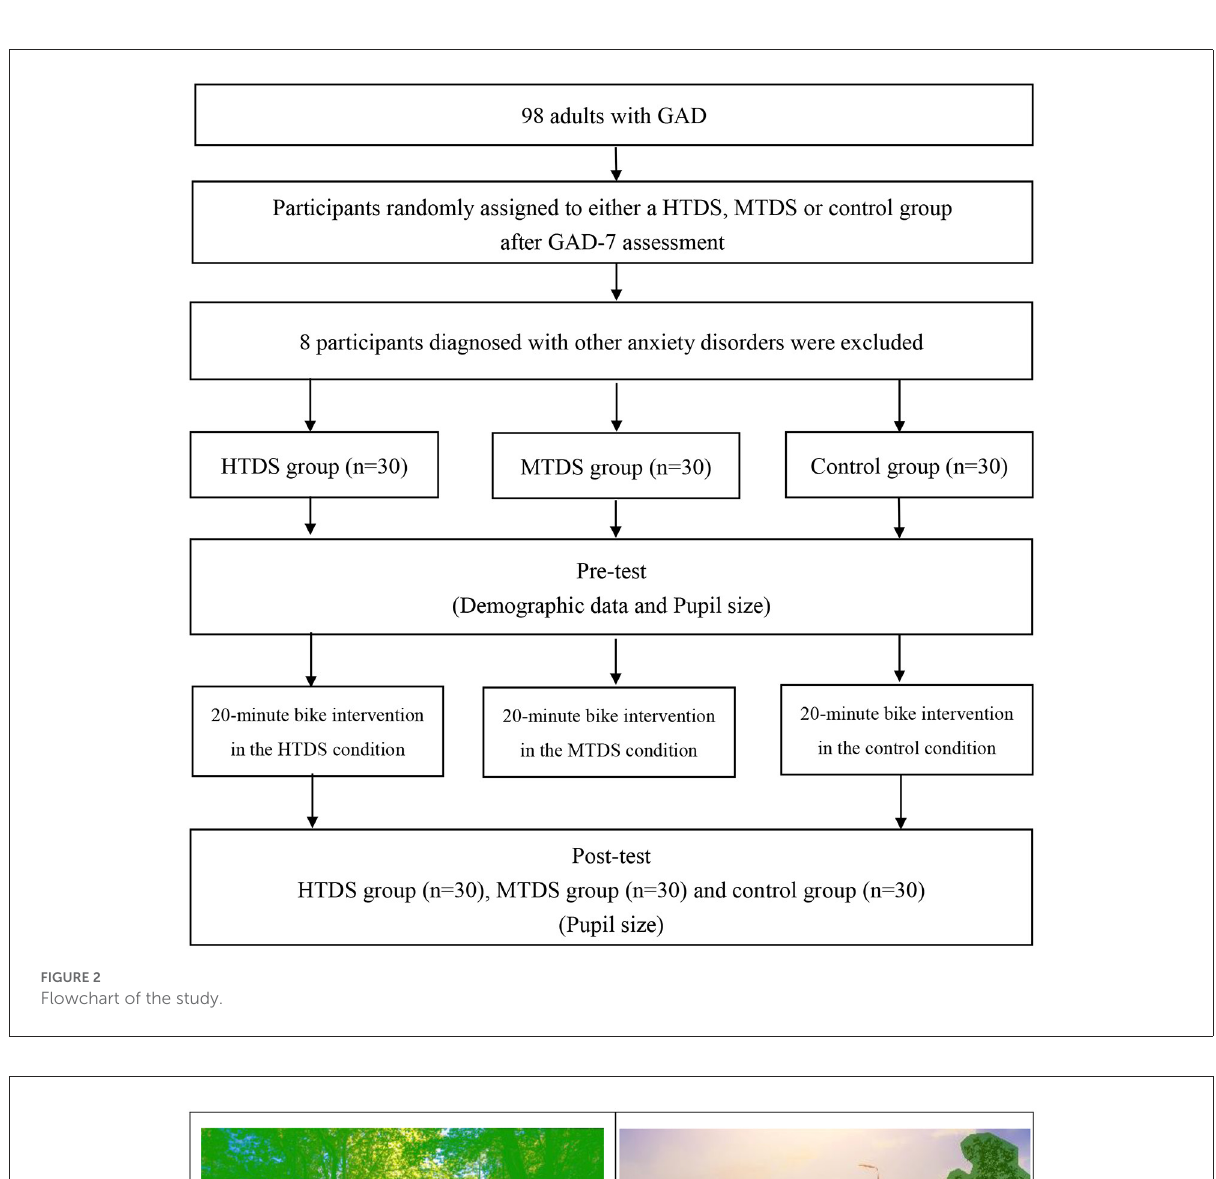
FIGURE2 Flowchart of the study.